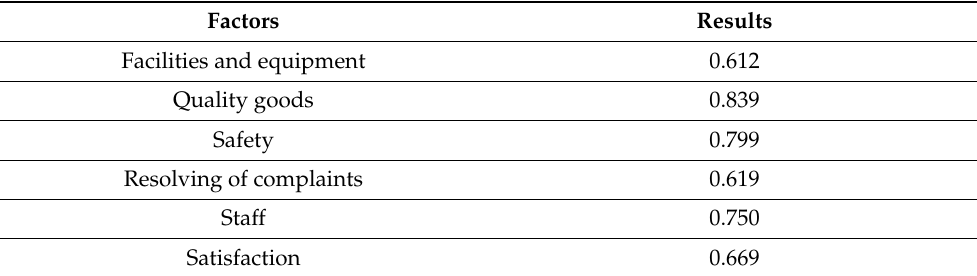
Table 2. Cronbach’s alpha